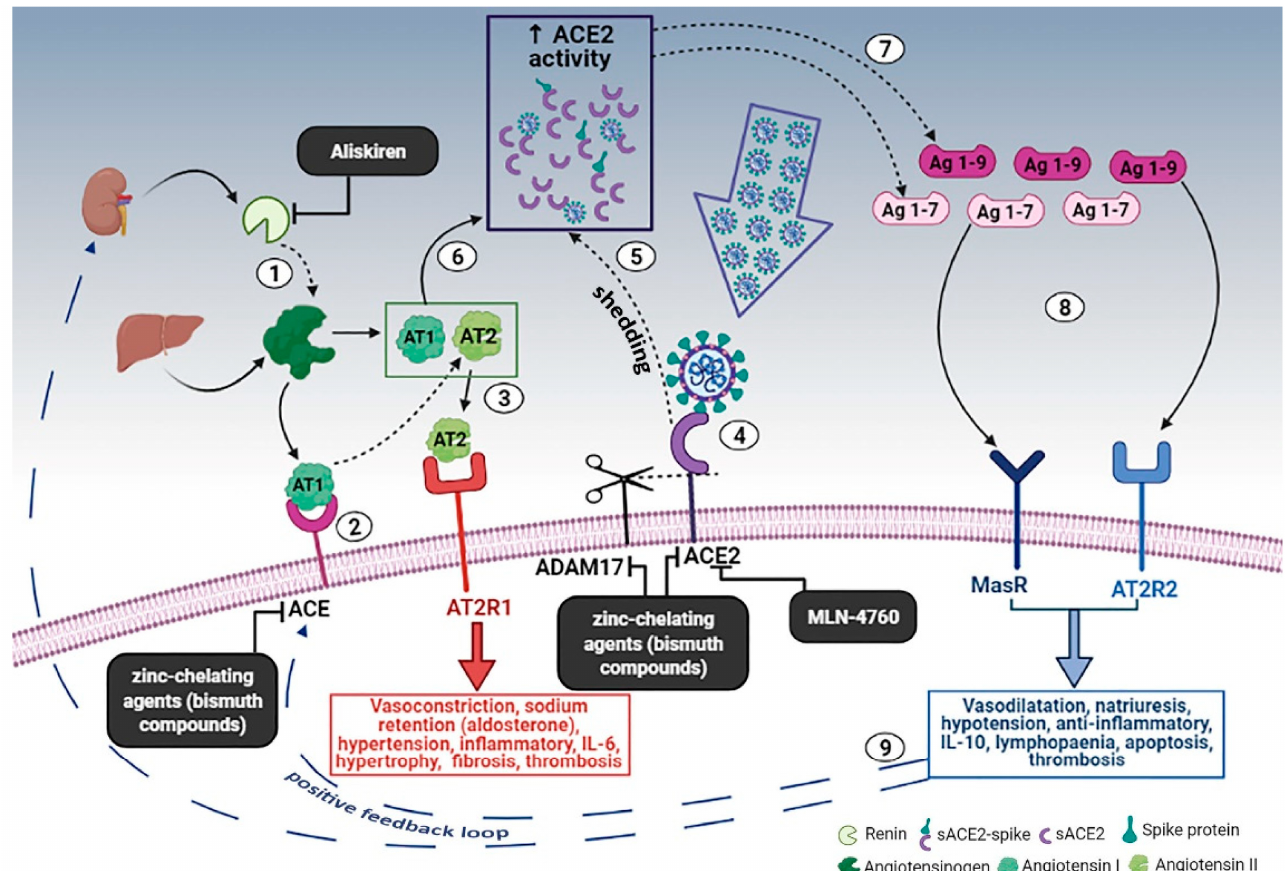
Figure 1. Schematic diagram of the effects of the RAAS system during SARS-CoV-2 infection and the proposed treatment. (1) Renin secreted by the kidney cleaves angiotensinogen, produced by the liver, to form AT1; (2) AT1 is converted to AT2 by pulmonary ACE. (3) AT2 binds to AT2R1 (angiotensin II receptors 1). The excess of AT2 through AT2R1 hyperactivation causes vasoconstriction, sodium retention (by aldosterone release), hypertension, inflammatory, IL-6, hypertrophy, fibrosis, and thrombosis. (4) SARS-CoV-2 binds to ACE2 to enter the host cell; however, the cellular protective response leads to ACE2 shedding. (5) ADAM17-regulated ectodomain shedding of ACE2 results in an increased amount of soluble and active ACE2 (sACE2). (6) AT1 and AT2 can also bind to sACE2. (7) They are then metabolized by ACE2 into Ag 1–9 and Ag 1–7, respectively. (8) The excess of Ag 1–9 and Ag 1–7 signaling via AT2R2 and MasR can induce vasodilatation, natriuresis, hypotension, anti-inflammatory effects, IL-10, lymphopenia, apoptosis, and thrombosis. (9) These events, in turn, produce a compensatory upregulation of both renin secretion and ACE activity, which establish the onset of a positive feedback loop. In the black boxes, drugs that can potentially stop the positive feedback loop by inhibiting enzymes of the RAAS are indicated. Dashed arrows indicate enzymatic activity, full arrows indicate non-enzymatic passage, and dashed blue arrows represent the positive feedback loop. Created in Bio-render.com. Reprinted from Ref.